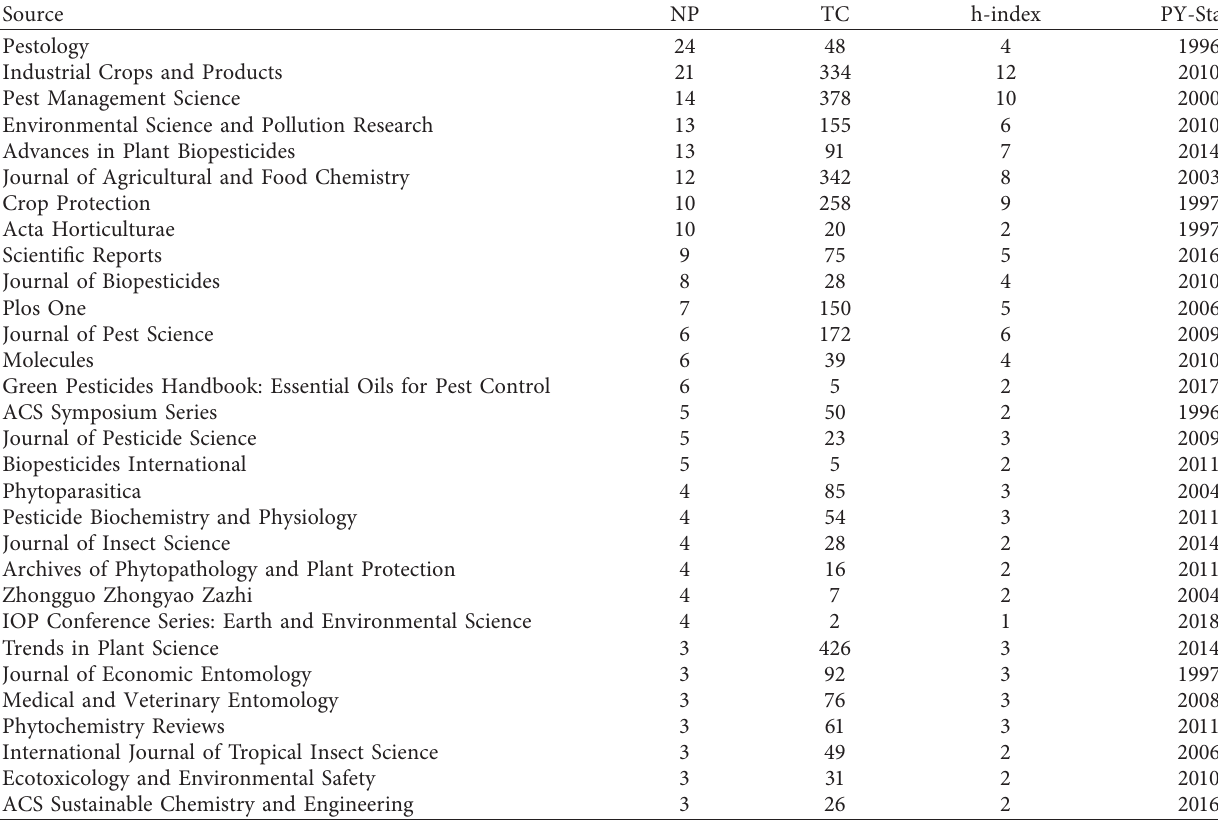
Table 5: Top 30 productive journals, the total number of publications, total citations, h-index, and publication start year, from 1994 to 2019.